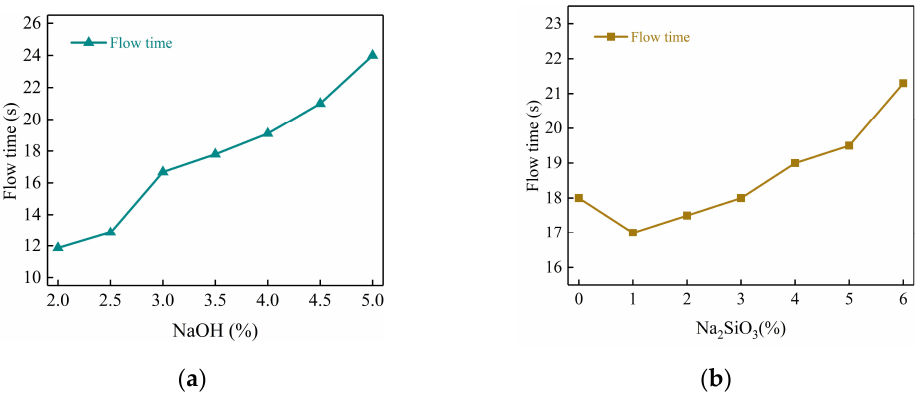
Figure 20. Effect of alkali activator on fluidity. ( a ) NaOH; ( b ) Na 2 SiO 3 .